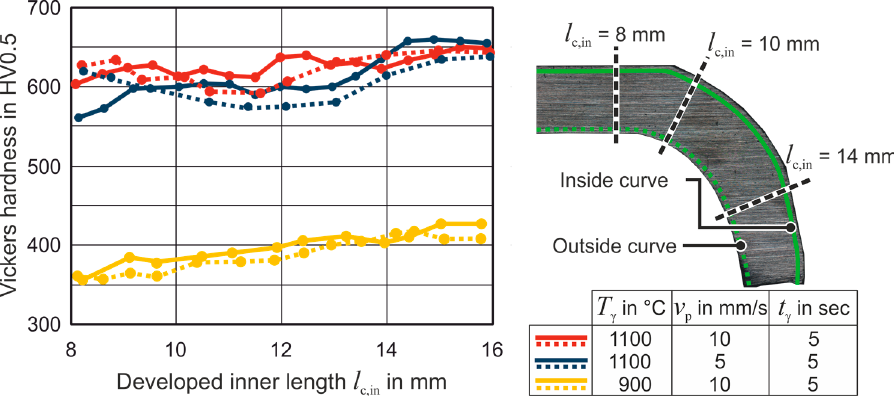
Figure 9. Distribution of hardness in the formed collar along the developed inner length l c,in with varying austenitizing temperature T γ and punch speed v p at a constant dwell time t γ of 5 s.